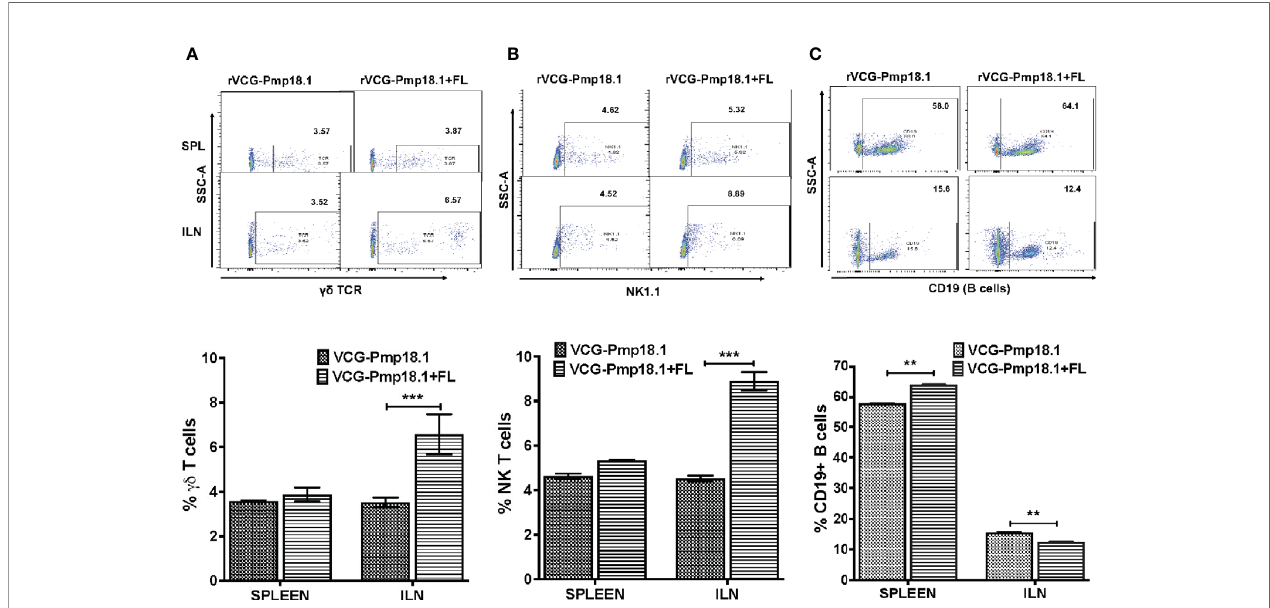
FIGURE 7 | Impact of co-delivery of FL adjuvant on the g d T cells, NK T cells and B cells in fi ltrating the mucosal and systemic immune inductive sites of mice immunized with rVCG-Pmp18.1 vaccine. Cells were isolated from spleens and ILN of immunized mice 4 weeks postimmunization. The cells were labeled with fl uorophore-conjugated anti- gd TCR, NK1.1 and CD19 antibodies and analyzed by fl ow cytometry. Representative fl ow cytometric images (top) and bar graphs (bottom) showing percentages of g d T cells (A) NK T cells (B) and B cells (C) in fi ltrating the spleen and ILN after immunization are shown. The results are shown as mean ± SD and represent two independent experiments ( fi ve mice in each group) with similar results. ** p < 0.01, *** p <